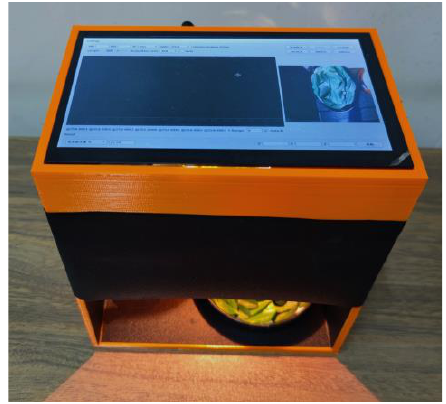
Figure 1. Tea leaf ingredient estimation sensor.